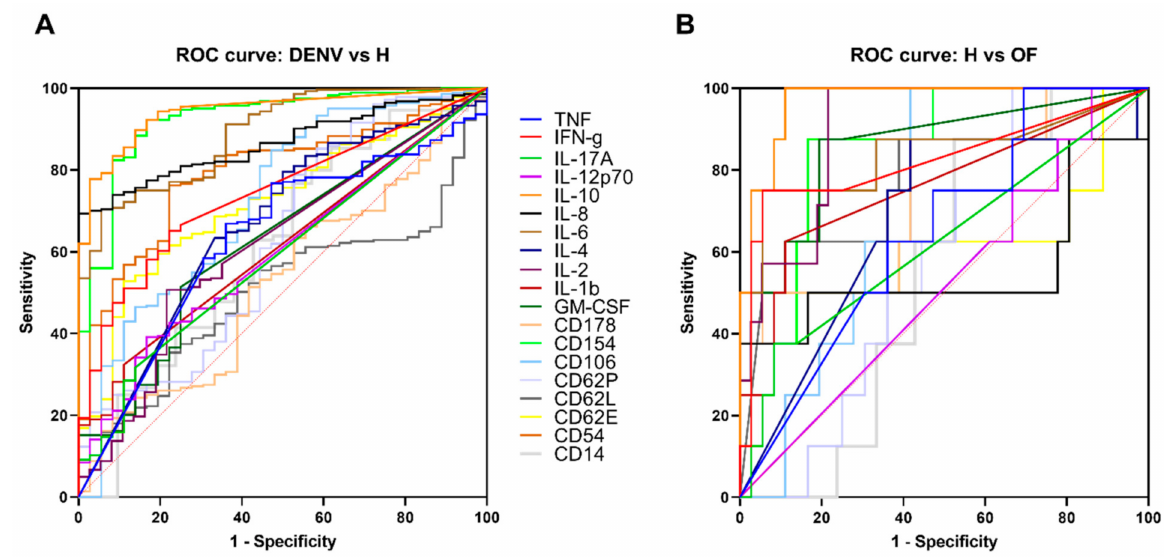
Figure 5. ROC curve of cytokines. Univariate logistic regression analysis was conducted. Performance of ROC curves of TNF, IFN-g, IL-17A, IL-12p70, IL-10, IL-8, IL-6, IL-2, IL-2, IL-1b, GM-CSF, CD178, CD154, CD106, CD62P, CD62L, CD62E, CD54 and CD14 for predicting DENV and differentiating from Healthy (H) and other fever (OF). Plots depict he tradeoff between sensitivity and specificity. The closer the curve follows the left-hand border and the top border of the ROC space, the more accurate the test. ( A ) ROC curve compared between DENV patients and healthy subjects. ( B ) ROC curve compared between healthy subject and other fever patients.